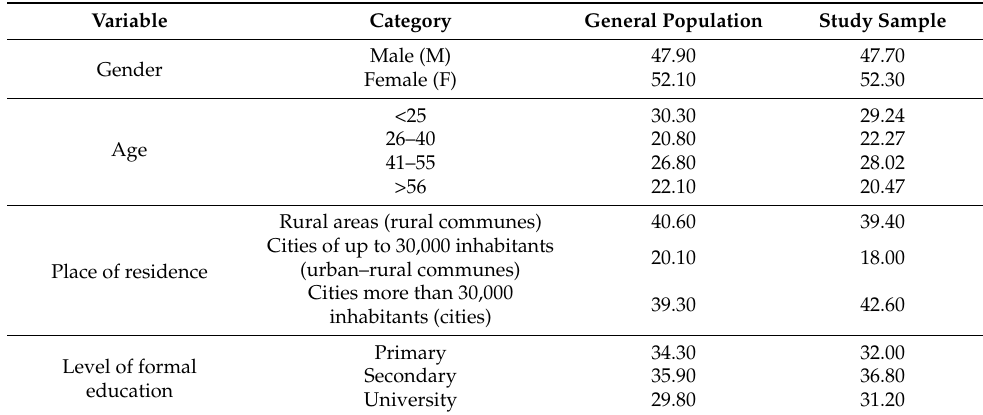
Table A1. Comparison of the Sample with the General Population